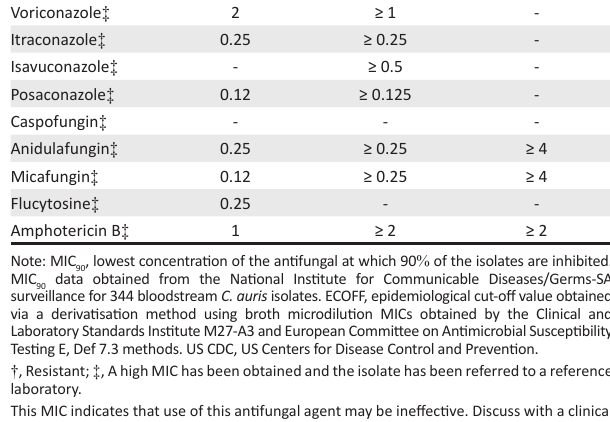
TABLE 2: Proposed cut-off values for Candida auris for 10 antifungal agents and corresponding South African surveillance MIC data. 90 Antifungal agent Minimum inhibitory concentration (MIC) (µg/mL) NICD surveillance data (MIC 90